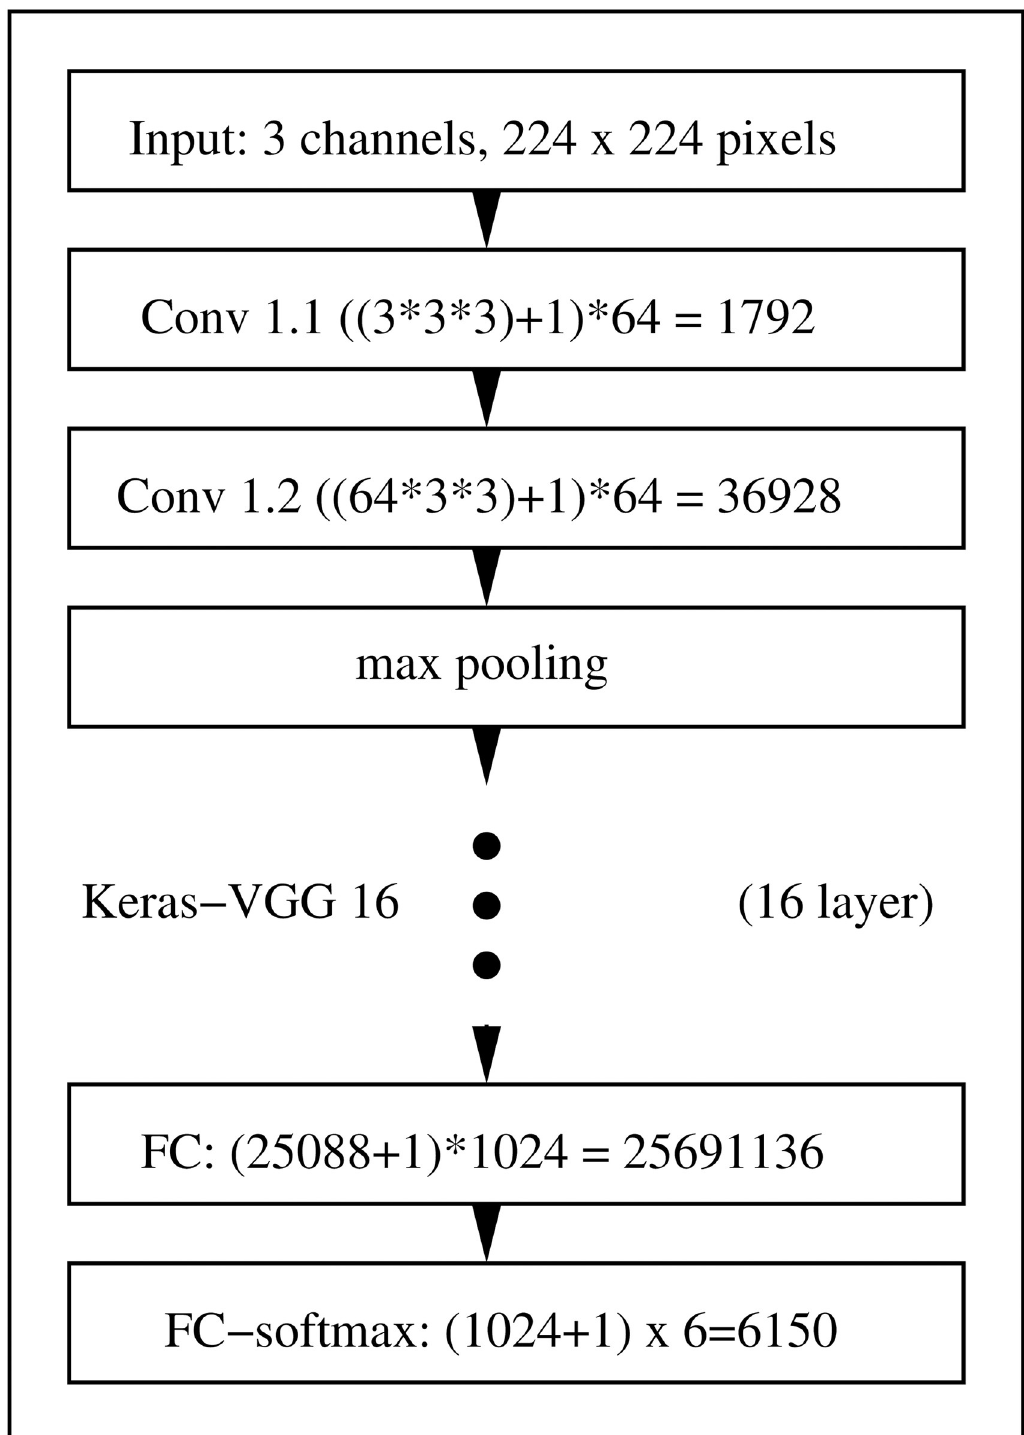
Fig 3. Sketch of the CNN architecture we use for predicting the lake of origin from 224 gray scale Nile tilapia images. Our architecture uses 16 layers. Except for the fully connected layers which use 1024 nodes and a 6 class softmax output layer, we apply the Keras version of VGG-16 by [24] which is inferred on ImageNet data [52].